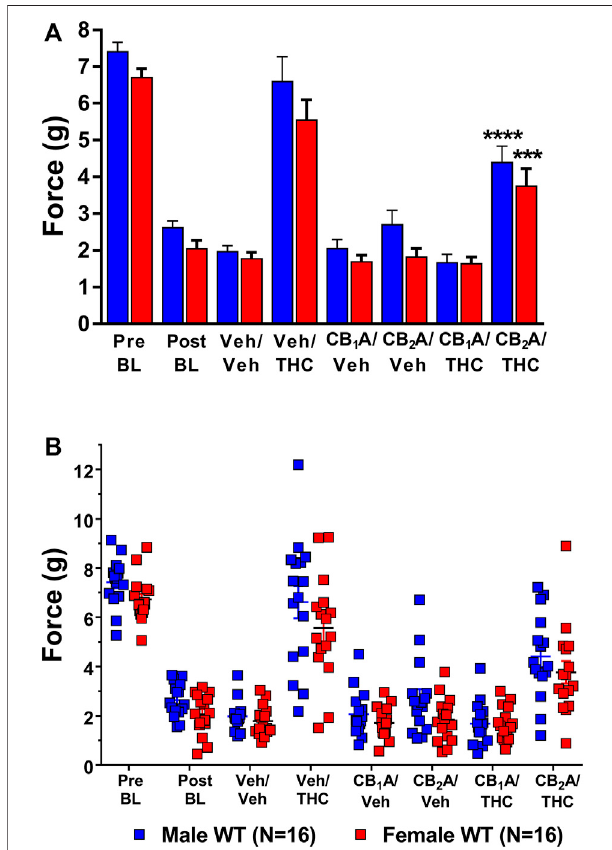
FIGURE 6 | Mediation of the anti-allodynic effects of 10 mg/kg Δ 9 -THC by CB 1 and/or CB 2 receptors. (A) Aggregate and (B) Individual Plots graphs showing male (blue squares) and female (red circle) wild-type (WT) mice showed a full reversal of allodynia following pretreatment with 10 mg/kg of Δ 9 -THC. Mice were treated and then assessed for the amount of force (g) required to elicit a paw withdrawal response 30 min are pretreatment with either vehicle, 10 mg/kg of the CB 1 receptor inverse agonist SR141716A, or 10 mg/kg of the CB 2 receptor inverse agonist SR144528 and again 60 min following treatment with either vehicle or 10 mg/kg Δ 9 -THC. Error bars represent the mean ± SEM. Each mouse was tested in triplicate and those values averaged to determine a single value for each mouse each day of testing. Data were analyzed using a two-way ANOVA with Bonferroni post- hoctests.[*** p < 0.001; ****p < 0.0001;comparedtobothpre-(Pre)andpost- (Post) Cisplatin baselines (BL)]. Sample sizes for each dosing combination (shown in parentheses) include 16 male and 16 female WT